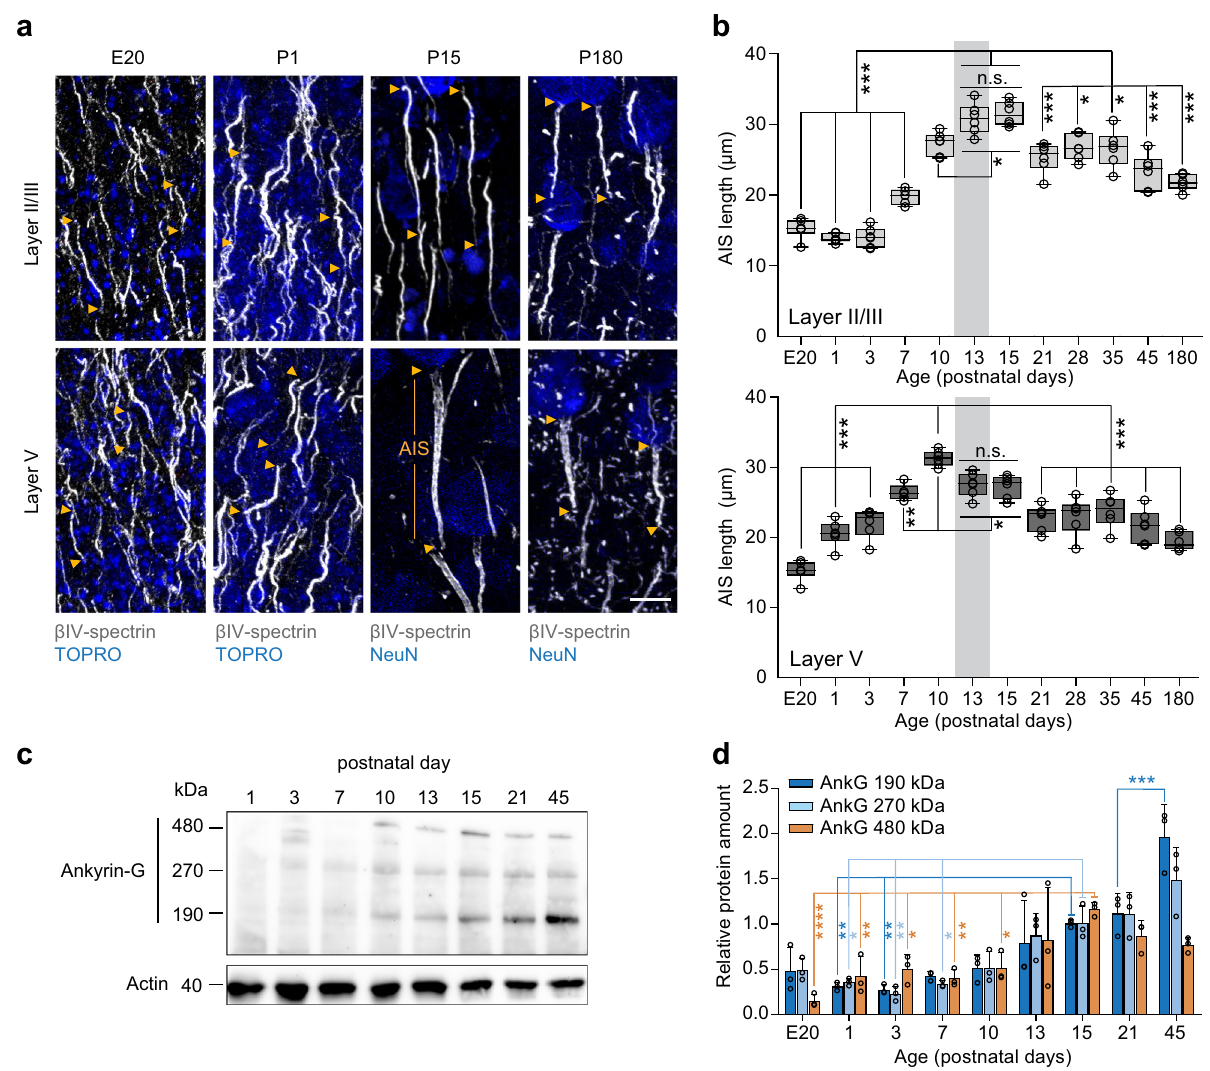
Fig. 1 AIS development in S1BF in vivo. a Representative confocal images of AIS length maturation for one embryonal and three postnatal ages (E20, P1, P15, and P180) in cortical layers II/III and V. Immunostaining against ßIV-spectrin (gray), TOPRO (blue) or NeuN (blue) as indicated. Note the long AIS at P15 in both layers and the appearance of nodes of Ranvier in P180 animals. Arrowheads indicate start and end of AIS; orange lines indicate extent of a single AIS at P15. Scale bar 10 µ m. b Population data of AIS lengths from E20 to P180 in layer II/III (top) and V (bottom). E20 data was pooled for supra- and infragranular layers. Initially, AIS length increases until P13 – 15, after which it decreases. Gray bars indicate the onset of active exploration and whisking (P12 – 14). Adult animals maintain an intermediate AIS length throughout life (for layer II/III and layer V, One-way ANOVA *** P < 0.001, Holm – Sidak ’ s post- hoc comparisons, n = 6 biologically independent experiments per age group, n = 5 biologically independent experiments for P7; >100 AIS per animal. For all comparisons, * P < 0.05, ** P < 0.01, *** P < 0.001, summary of P values see Tables S1 and S2). Boxplots: median with 25 – 75% interval, error bars show minimum to maximum values. c Representative immunoblot of the major ankG isoforms (190, 270, 480 kilodalton, kDa) for postnatal developmental expression of the main ankG 480 kDa isoform peaks at P15 (Two-way ANOVA *** P < 0.0001 for time, * P = 0.067 for isoform, *** P = 0.0007 (time x isoform) for the interaction, n = 3 biologically independent experiments per age group, Tukey ’ s multiple comparisons tests * P < 0.05, ** P < 0.01, *** P < 0.001, only a selection of statistical comparisons are depicted for visualization. Summary of all P values in Table S3). Data shown as mean ± points in Group 1 in layers II/III (Two-way ANOVA P < 0.0001 conducting sensory deprivation experiments via daily, bilateral (deprivation), Fig. 2b, c), but not in layer V (measured at P15 and whisker trimming from birth (P0) to P15, P21, and P45, respec- P21, Two-way ANOVA P = 0.20 (deprivation), Fig. S2a). In a tively (Group 1, Fig. 2a – c). P15 coincides with the closure of the second group, we applied a shorter trimming period of 5 days critical period for layer IV to II/III synapses 36,43 , while P21 was identi fi ed as the time point of signi fi cant AIS length reduction (P10 – P15). However, this did not lead to AIS length changes in during development (Fig. 1b). At the P15, P21, and P45 endpoints, layer II/III (Two-way ANOVA P = 0.33 (deprivation) Fig. 2a, d), mice were perfused and S1BF cryosections examined via immu- indicating a minimum of 2 weeks of deprivation to induce sig- no fl uorescence and morphometrical analysis of AIS length in layer ni fi cant length changes during development. Length frequency II/III (Fig. 2b) and layer V (Fig. S2a) neurons. Bilateral whisker distribution analysis of the AIS in Group 1 showed that with trimming resulted in a signi fi cant lengthening of AIS at all time whisker trimming until P15, the number of longer AIS signi fi cantly